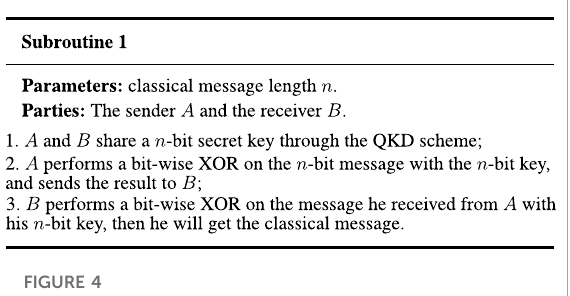
FIGURE 4 Transportation of a classical message from one party to another, while no third party can get any information about this